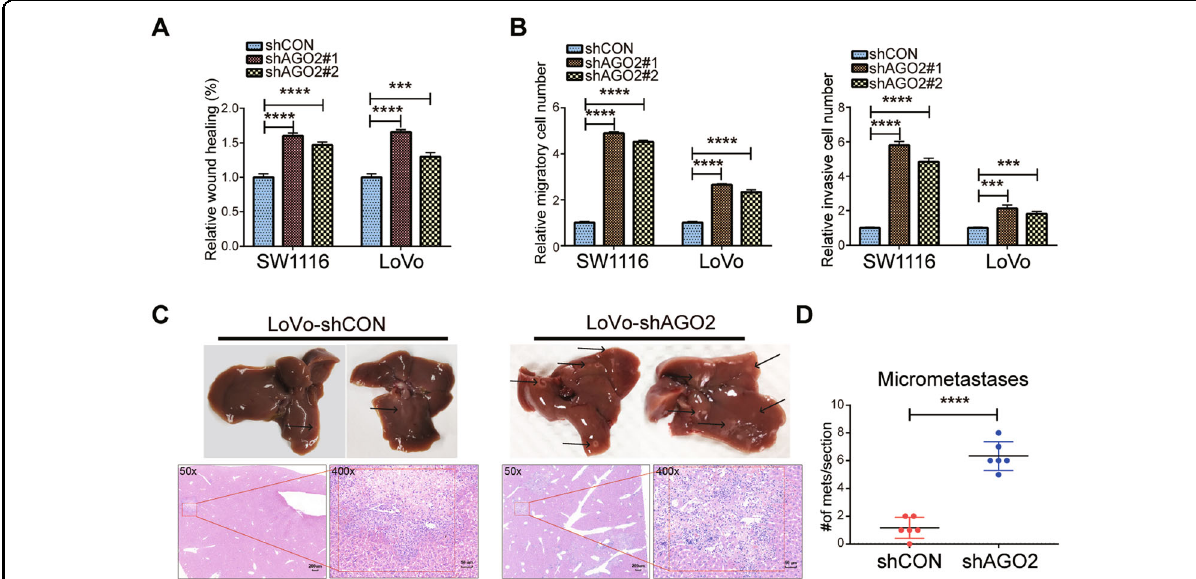
Fig. 3 AGO2 knockdown promotes the migration, invasion, and metastasis of CRC cells. A , B Statistical analyses of cell migration and invasion were determined by wound healing ( A ) and Transwell assays ( B ) upon AGO2 knockdown in CRC cells. C Metastatic foci (upper) and H&E-staining images of metastatic nodules (bottom) from mice are shown; scale bars are 50 and 200 μ m. D The number of liver metastatic nodules was analysed ( n = 6 per group). Data are shown as the mean ± SD. *** p < 0.001, and **** p <